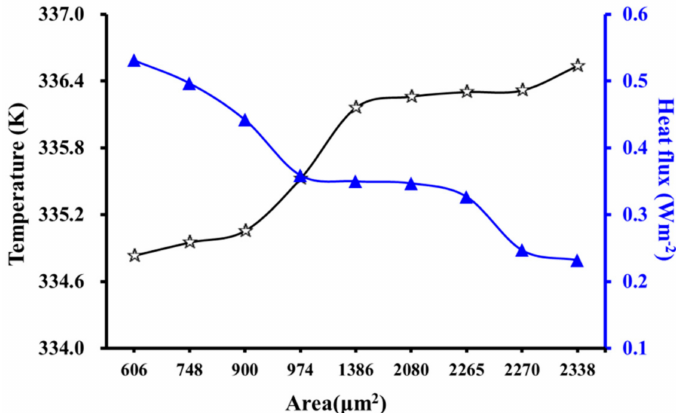
Figure 12. Influence of cross-sectional area on temperature and heat